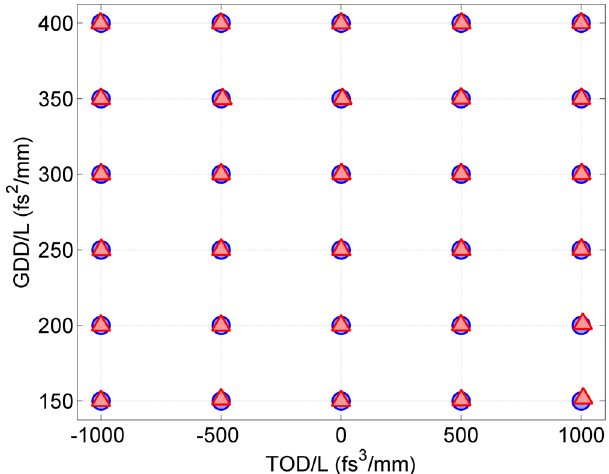
Figure 1. Retrieval of the dispersion introduced in the simulations. Comparison between the GDD/L and TOD/L values in the simulated and retrieved d-scans. Blue circles: simulated values; red triangles: retrieved values.